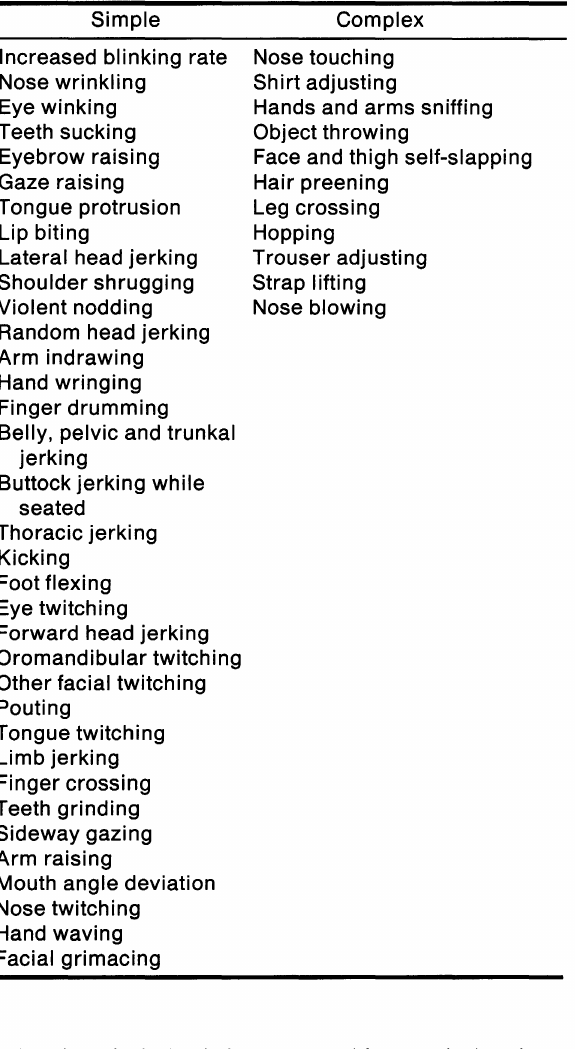
TABLE I. Motor tics in 75 patients with